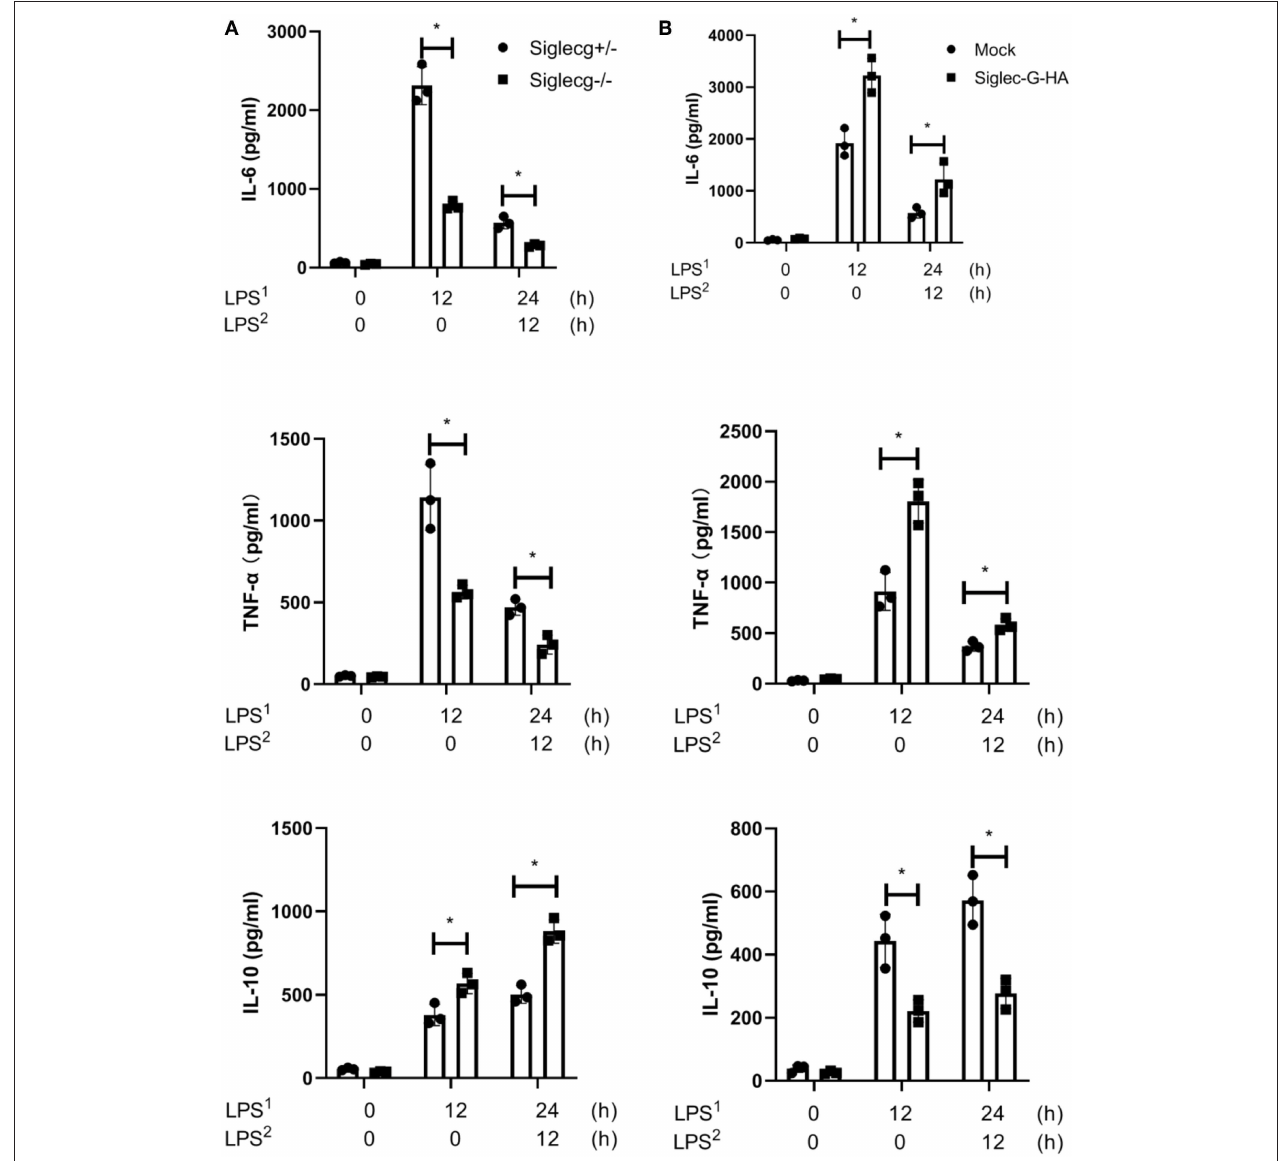
FIGURE 2 | Siglec-G orchestrates TLR-triggered pro-inflammatory and anti-inflammatory cytokines production in macrophage. ( A ) ELISA of IL-6, TNF- α , and IL-10 in supernatant from Siglecg + / − and Siglecg − / − peritoneal macrophages (6 × 10 5 ) that were stimulated with first round of LPS (100ng/ml) as indicated or were changed with then fresh medium for the second round of LPS for 12h. (B) ELISA of IL-6, TNF- α , and IL-10 in supernatant from Siglec-G-overexpressing RAW264.7 macrophages (8 × 10 5 ) stimulated with LPS as (A) . Data are representative of three independent experiments with similar results and presented as means ± SD. * P < 0.01. TLR, toll-like receptor; IL, interleukin; TNF- α , tumor necrosis factor- α ; LPS, lipopolysaccharide.